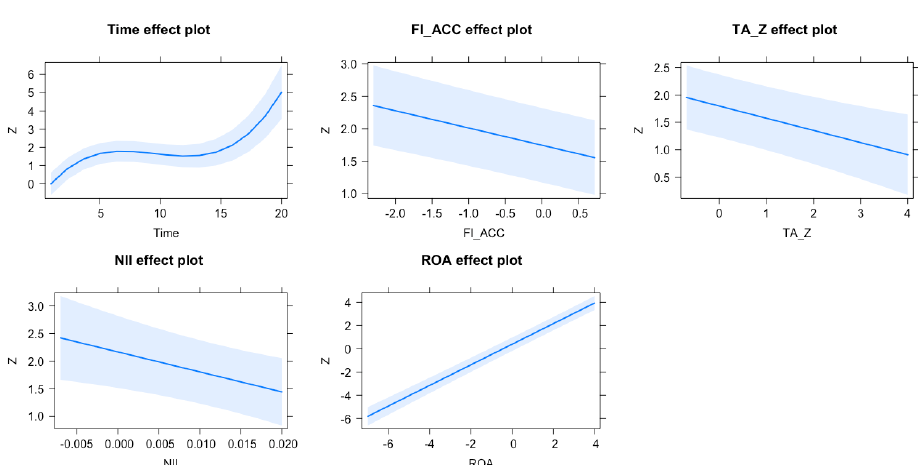
Figure 4. Significant factor effect plots for conventional banks.